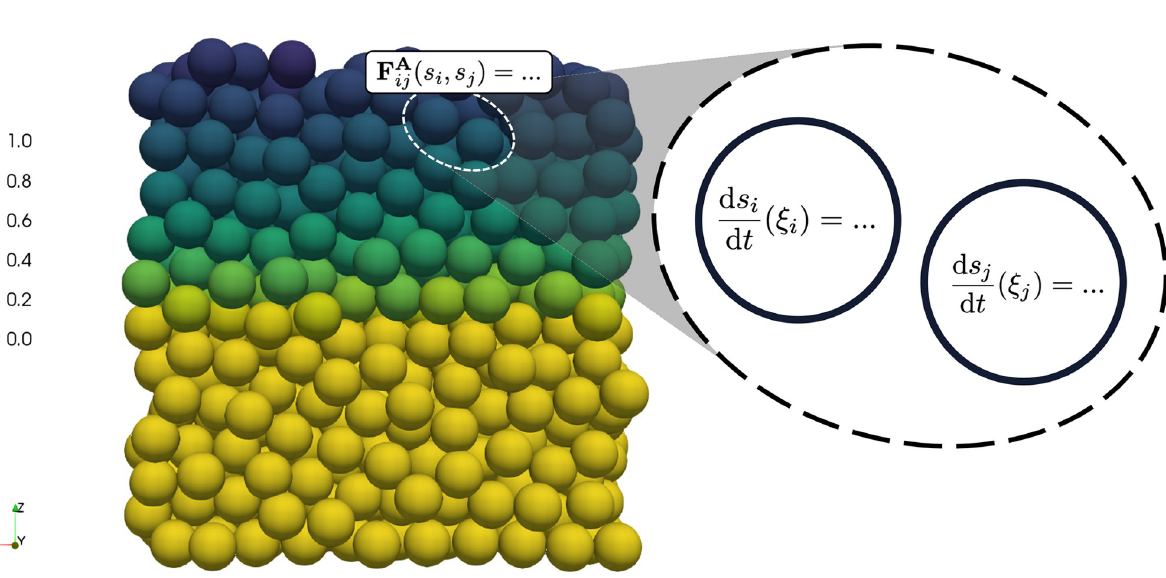
Fig 3. Diagram of the coupling between the multicellular and the subcellular scales. Cells are coloured by their proportion of remaining ) from the multiscale model, updates the corneodesmosome. The cell gets its vertical location, normalised by corneum thickness and start height, ( ξ i subcellular model parameters and solves for that time step, and then returns the updated proportion of remaining corneodesmosomes ( s i ) to the multicellular model to scale cell-cell adhesion ( F A ij